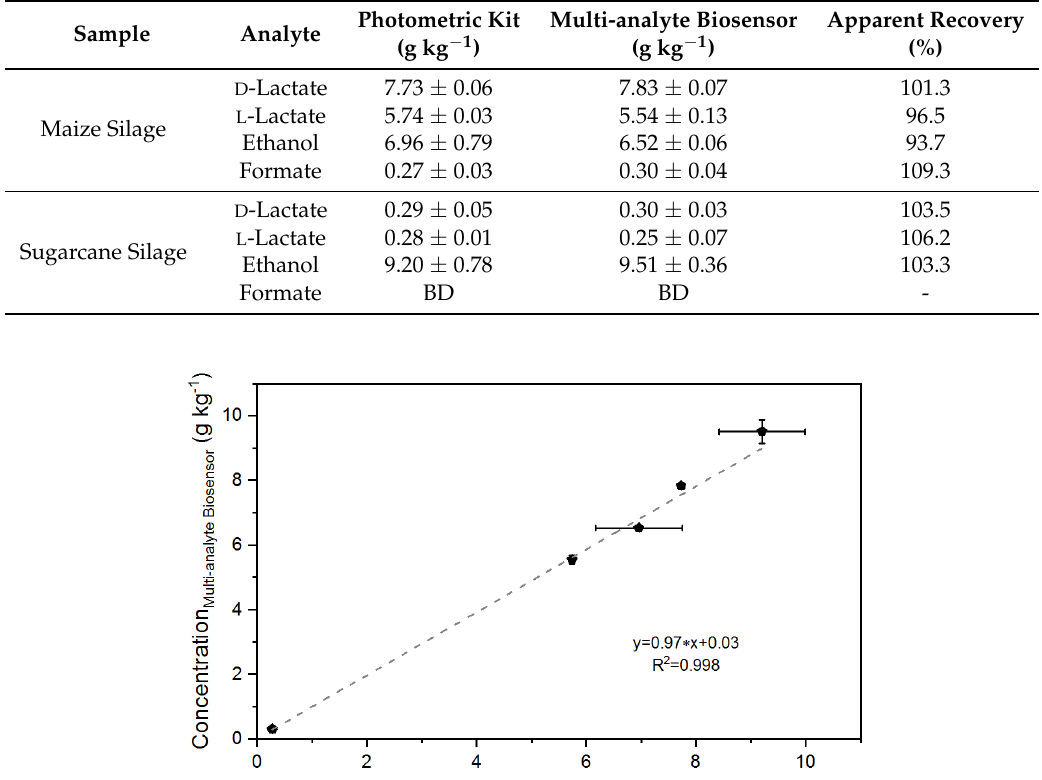
Table 2. Determination of organic acids in silage samples using two different analytical techniques (BD: below the lower detection limit).